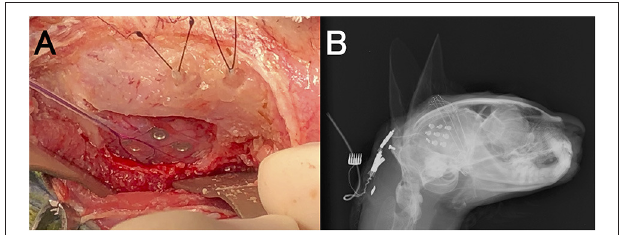
FIGURE 5 | Placement of intracranial electrodes. (A) Implantation of a 9-channel ECoG grid (on the dura covering the temporo-occipital cortex) and depth electrodes (into the hippocampus and amygdala). (B) Lateral radiograph after implantation of intracranial